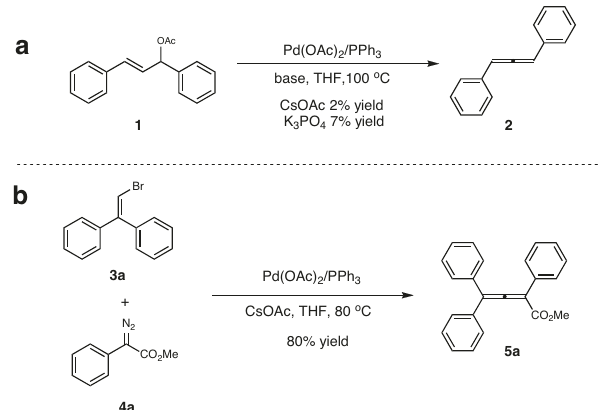
Fig. 2 Initial studies. a Allene synthesis starting from allyl acetate 1 . b Allene synthesis starting from vinylbromide 3a and diazoacetate 4a .